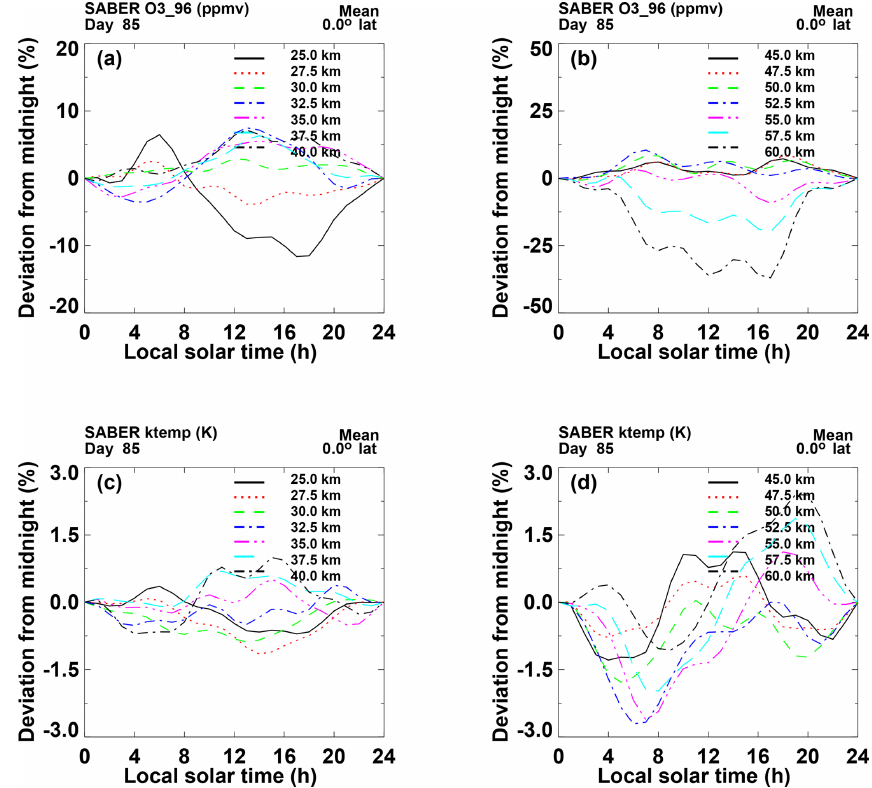
Figure 1. (a, b) Ozone zonal mean mixing ratios (ppmv) versus local time for day 05085 at the Equator. (a) At 25 to 40km (percent deviation from midnight) and (b) 45 to 60km. (c, d) As in (a, b) , but for temperature